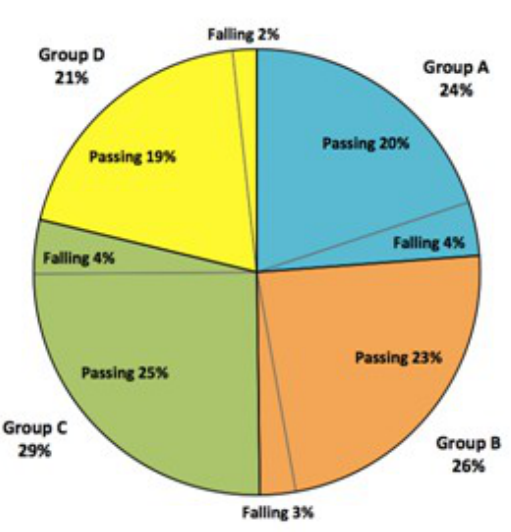
Figure 4. Percentage and number of passing/failing students by group. Academic year 2013/2014